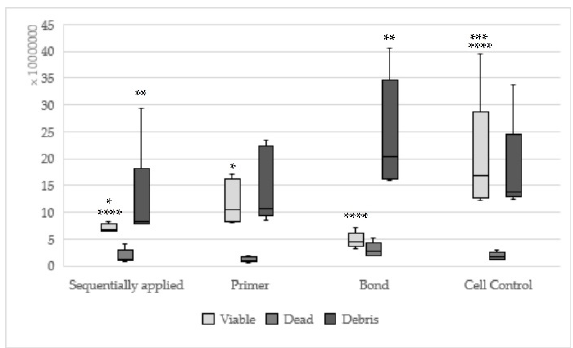
Figure 3. Results of One-up Bond F Plus sequentially applied, single applied (Agent A, Agent B) and Cell control (same asterisks show significant differnces in the corresponding groups). Materials 2020 , 13 , x FOR PEER REVIEW